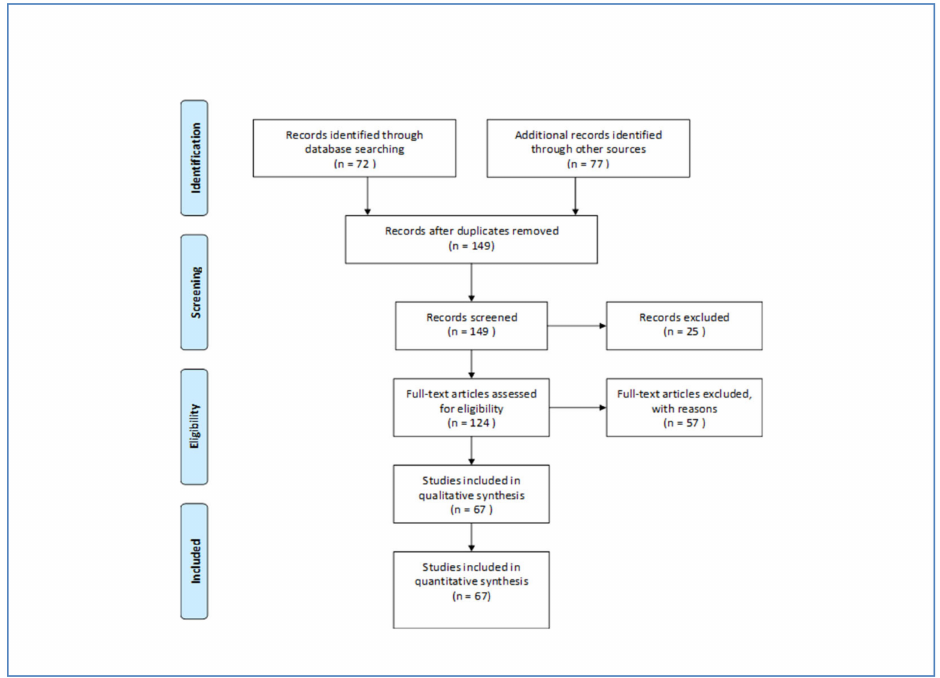
Figure 1. Flow chart of selection procedure and search